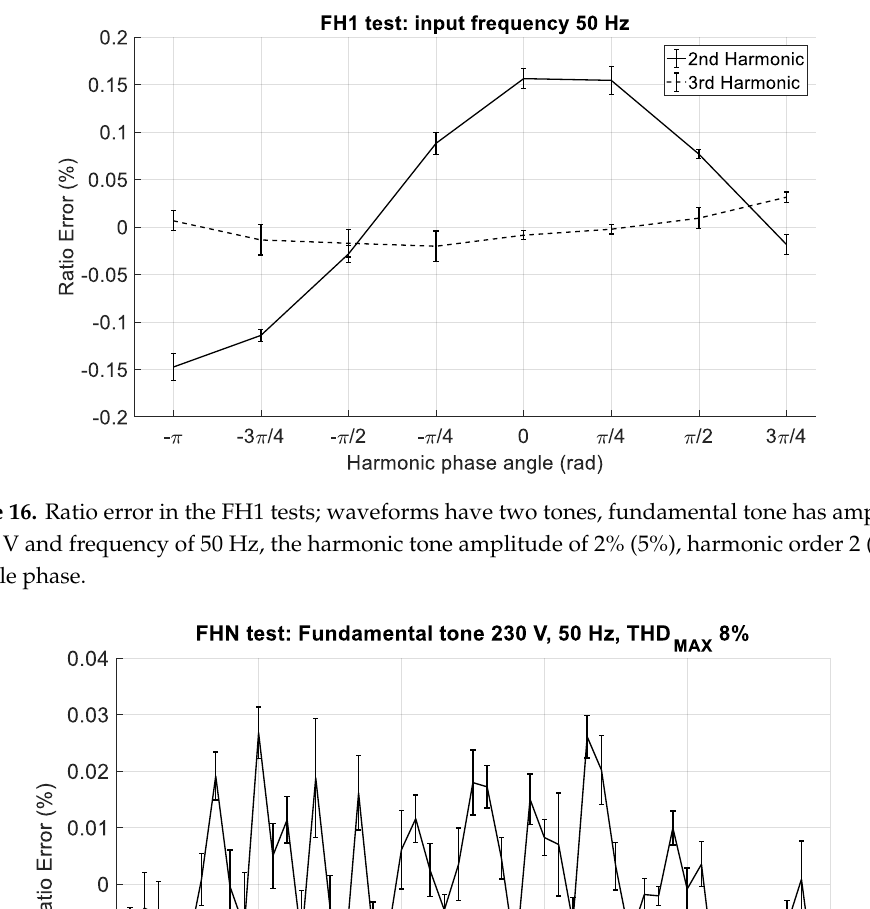
frequencies from 49.5 Hz to 50.5 Hz.